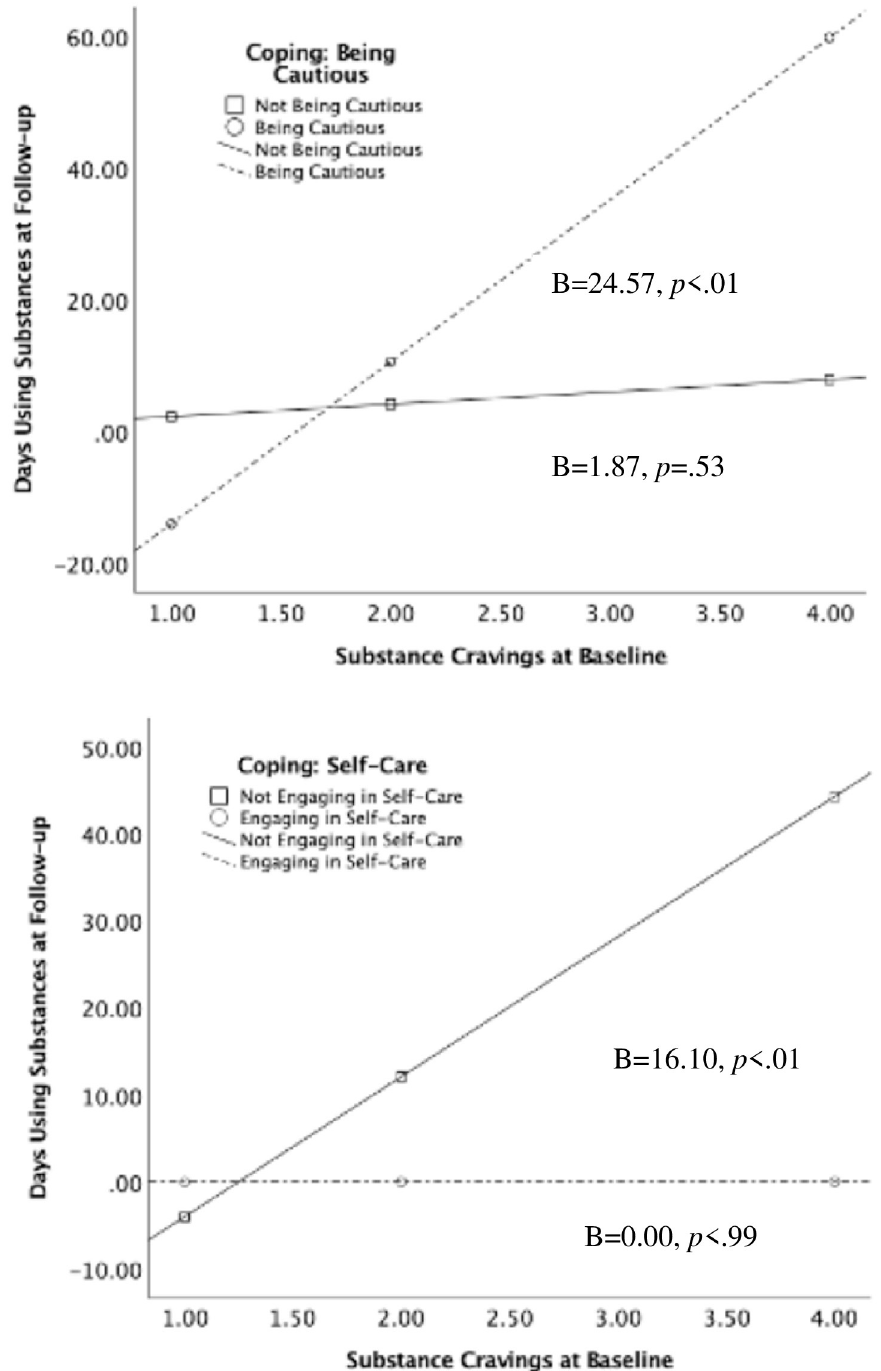
Fig 2. Interactions between baseline substance cravings and coping strategies to predict later days using substances (n = 48). Top panel depicts the interaction with being cautious and Bottom panel depicts the interaction with